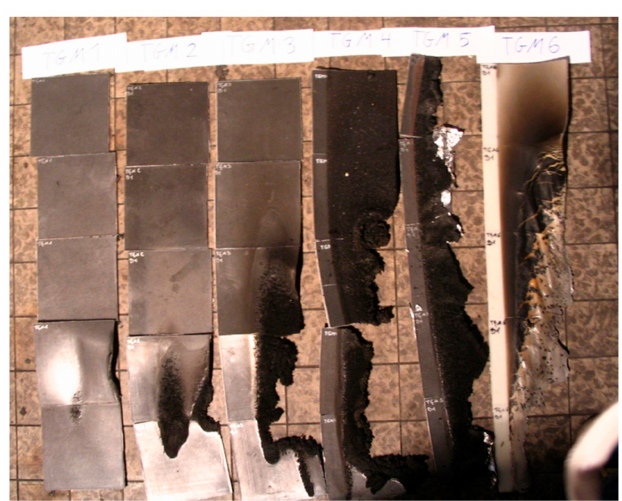
Figure 18. Test samples TGM 1 to TGM 6 after carrying out the Schlyter test. (TGM1: PP + 5%Gra, TGM2: PP + 5%Gra + 5%AlPh, TGM3: PP + 5%Gra + 5%MMT, TGM4: PP + 5%Gra + 5%AlPh + 5%MMT, TGM5: PP + 5%Gra + 5%MgOH, TGM6: PP + 5%MgOH).